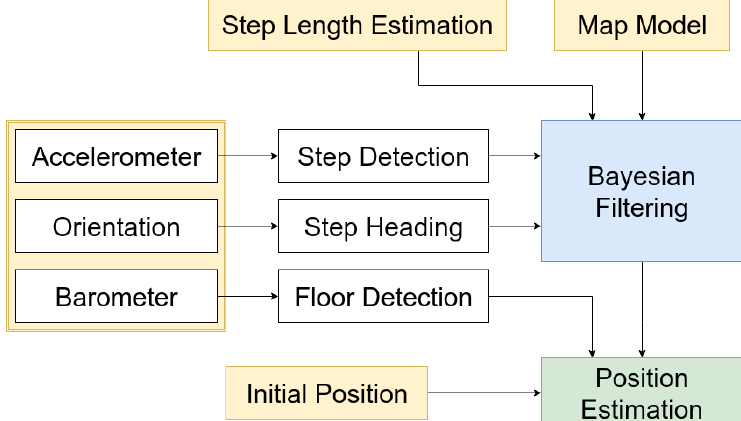
Figure 1. Solution Overview. The aim of the paper is to compare different Bayesian filtering